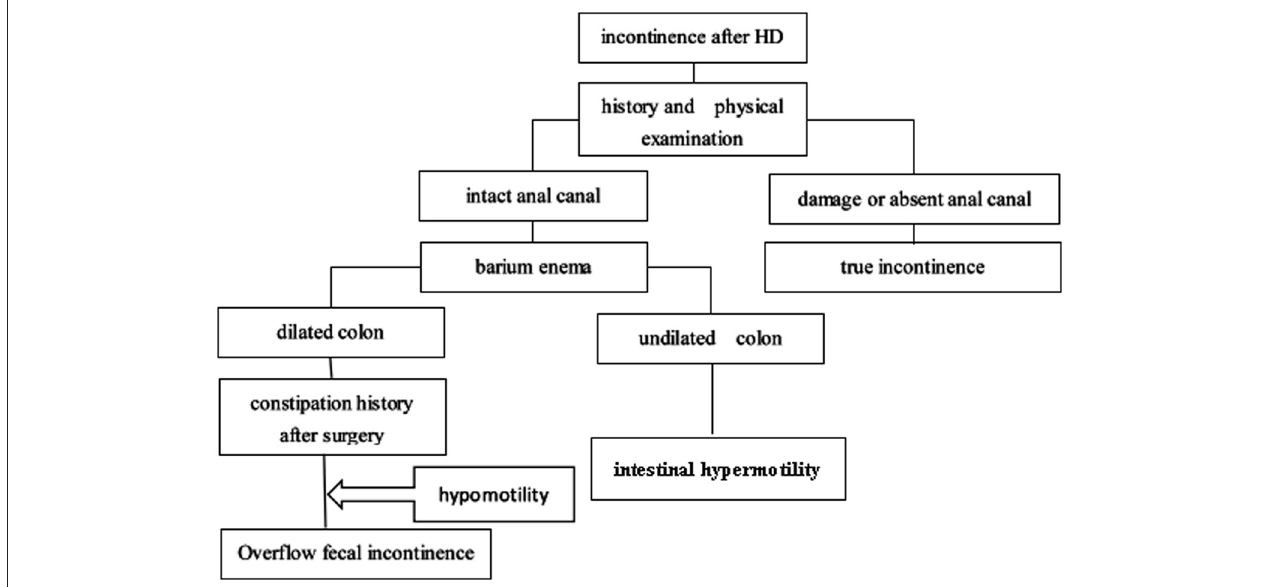
FIGURE 1 | Incontinence diagnosis